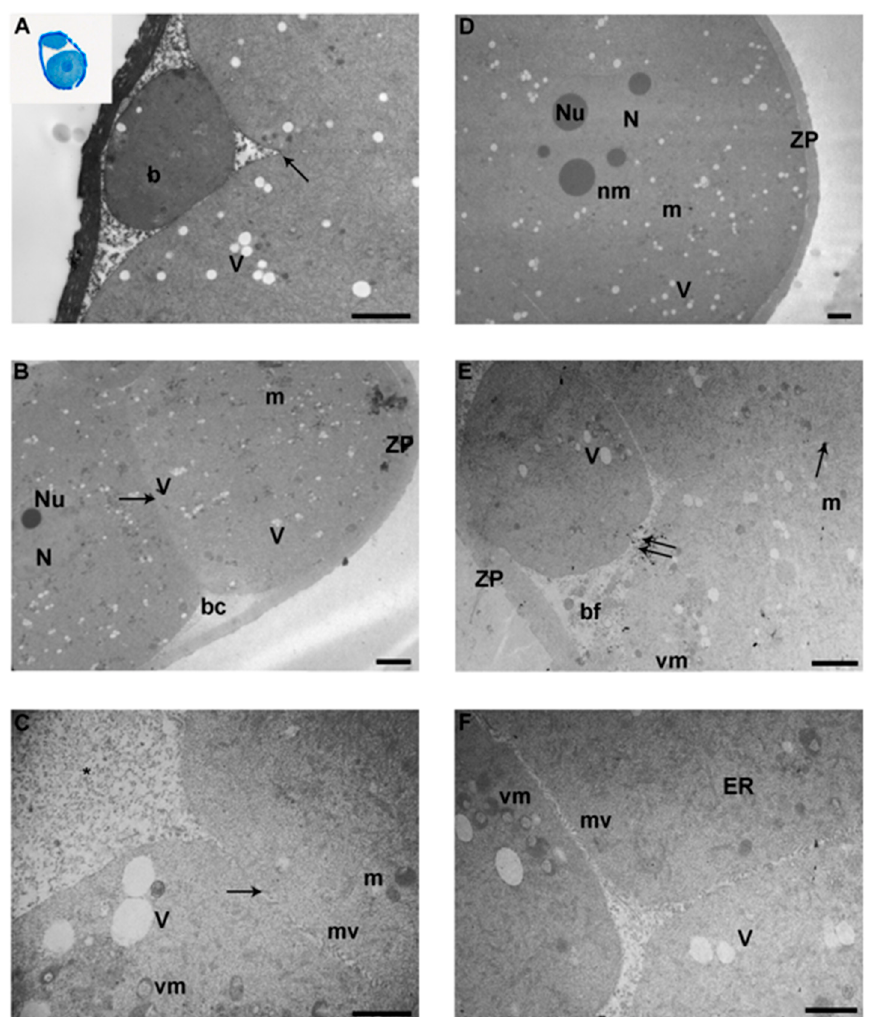
Figure 1. Ultrastructural evaluation of 2-cell and 4-cell embryos. A–C. Representative micrographs of 2-cell embryo groups. A. Transmission electron microscopy (TEM) micrograph of a 2-cell embryo of the IVF-5% group, showing a small blastomere forming (b). Arrows indicate the intercellular contacts (TEM. Bar: 2 µm). Inset in A. A representative image of a semithin section of a 2-cell embryo (LM. Mag: 40x). B. A representative picture of in vitro fertilized (IVF)-20% 2-cell embryo with evident nucleus (N) and nucleolus (Nu). Different blastomeres with cellular junctions (arrow) are visible (TEM. Bar: 4 µm). C. High magnification of IVF-20% 2-cell embryo adjacent blastomeres showing continuous intercellular contacts (arrow). Abundant cellular debris (*) is present in the inter-blastomeric space (TEM. Bar: 1 µm). D–F . Representative micrographs of 4-cell embryo groups. D. TEM micrograph of IVF-5% 4-cell embryo with evident nucleus (N) and nucleoli (Nu). Several vacuoles (V) and mitochondria (m) are evident. (TEM. Bar: 2 µm). E. Representative picture of IVF-20% 4-cell embryo showing numerous vacuoles (V), vacuolated mitochondria (vm) and blastomeric fragments (bf). Double arrows indicate the interruption of the intercellular contacts between blastomeres (TEM. Bar: 2 µm). F. TEM micrograph showing the inter-blastomeric cleft between 3 cells of IVF 20% (TEM. Bar: 1 µm). bc: blastocoel cavity; m: mitochondria; V: vacuoles; ZP: zona pellucida; vm: vacuolated mitochondria; mv: microvilli; arrow: intercellular contact; N: nucleus; nm: nuclear membrane; ER: endoplasmic reticulum.